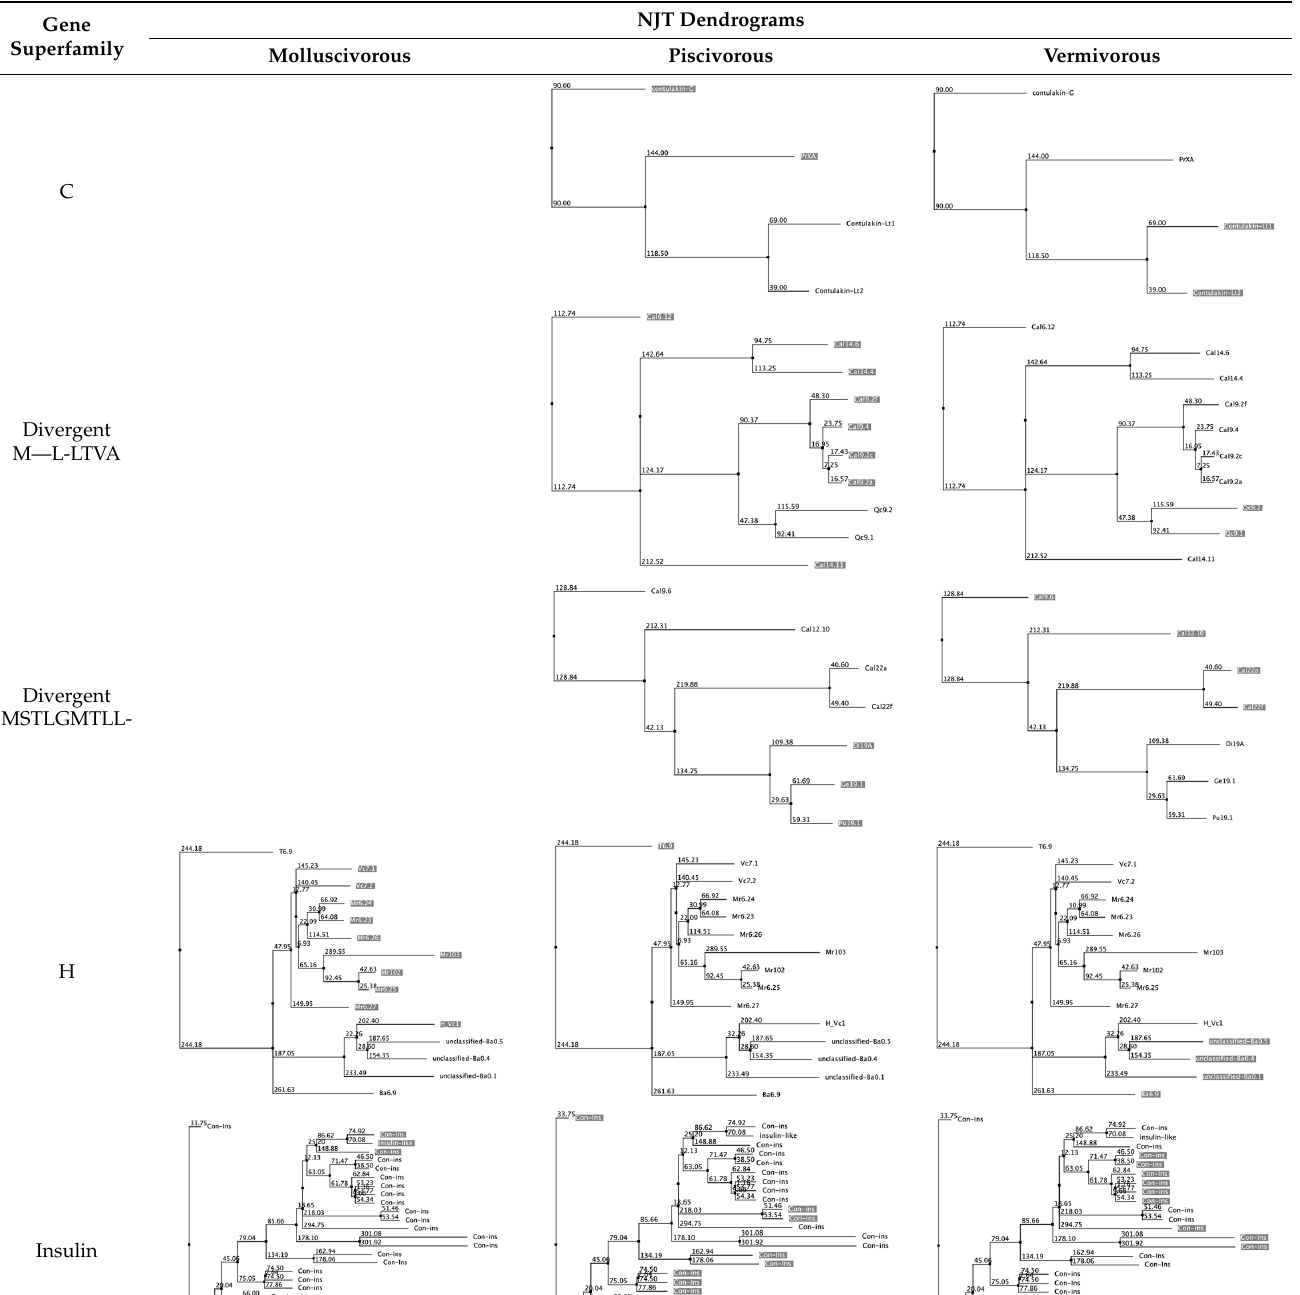
Table A2. Neighbor-joining trees for small sample sizes.